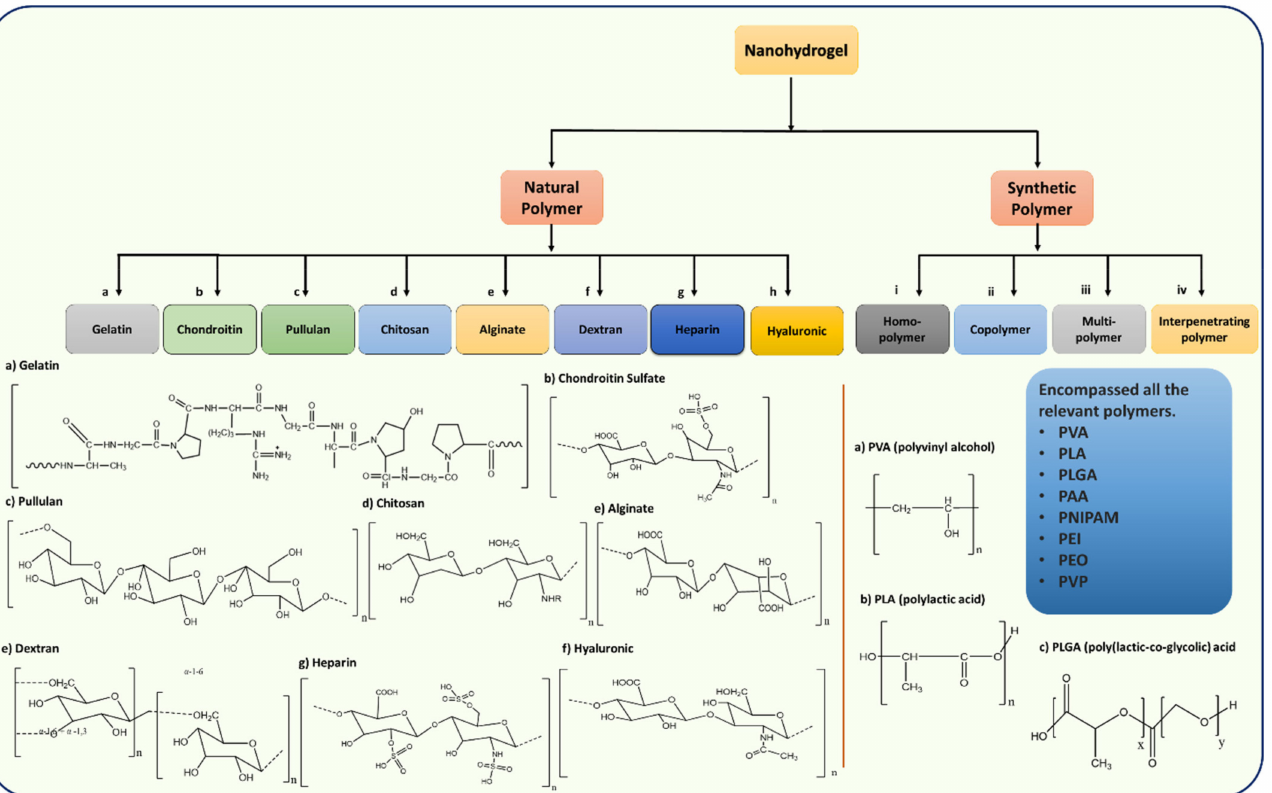
Figure 2. Schematic representation of the classification of nanohydrogels based on source and chemical structures of nanohydrogel’s natural and synthetic-based